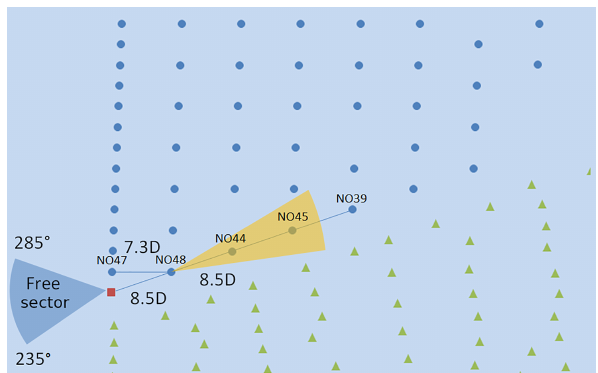
Figure 2. Nordsee Ost wind farm (blue circles) with neighbour- ing wind farm Meerwind Süd (green triangles), met mast (red square) and distance in rotor diameters (D). The orange area in- dicates the plan position indicator (PPI) scan from the Windcube 200S mounted on the helicopter platform of NO48 (described in Sect.